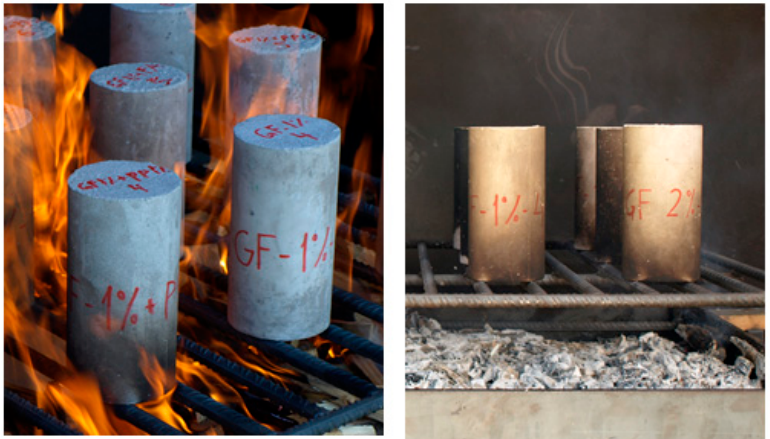
Figure 2. Fire test involving the entire surface of the test piece being directly exposed to the fire and taking measurements with an infrared thermometer.